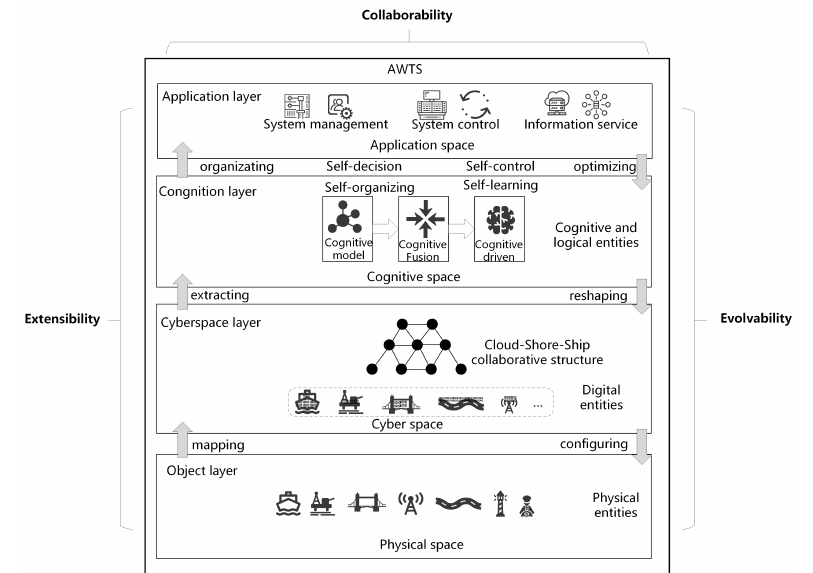
Figure 13. The architecture of an autonomous waterborne transportation